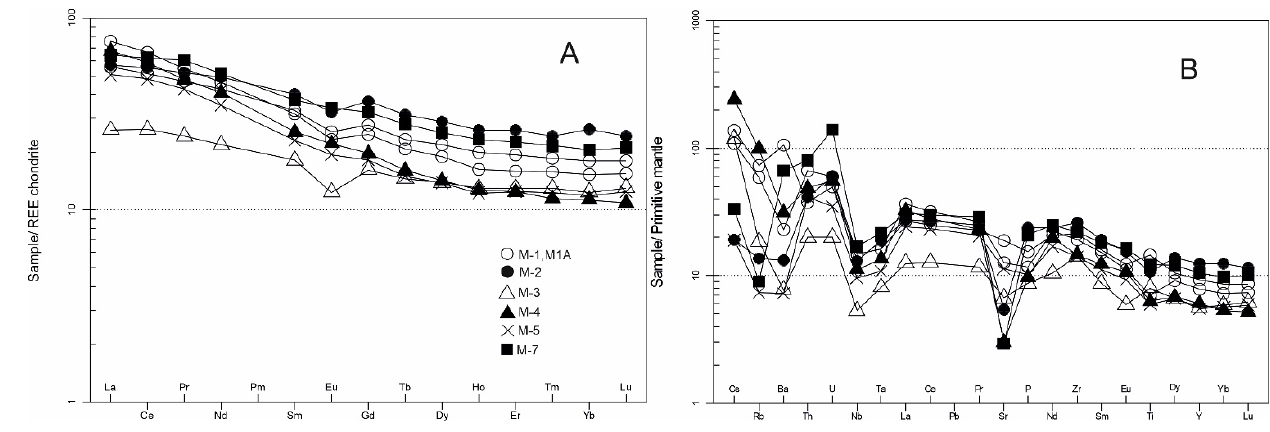
Figure 11. ( A ) REE concentration normalized to the chondrite composition [59]; ( B ) Trace element concentrations normalized to the composition of the primitive mantle [62]. Sample M-1—M7 from Table 7.